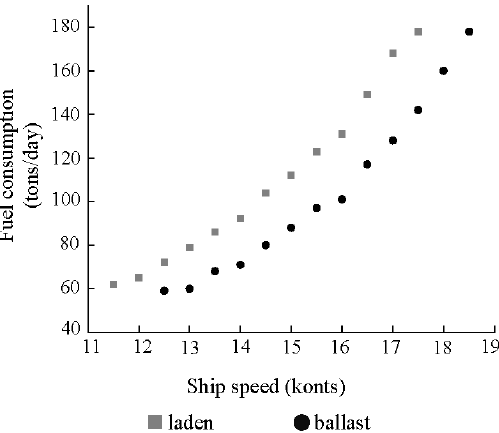
Figure 2. Typical fuel consumption function for a Very Large Crude Carrier.